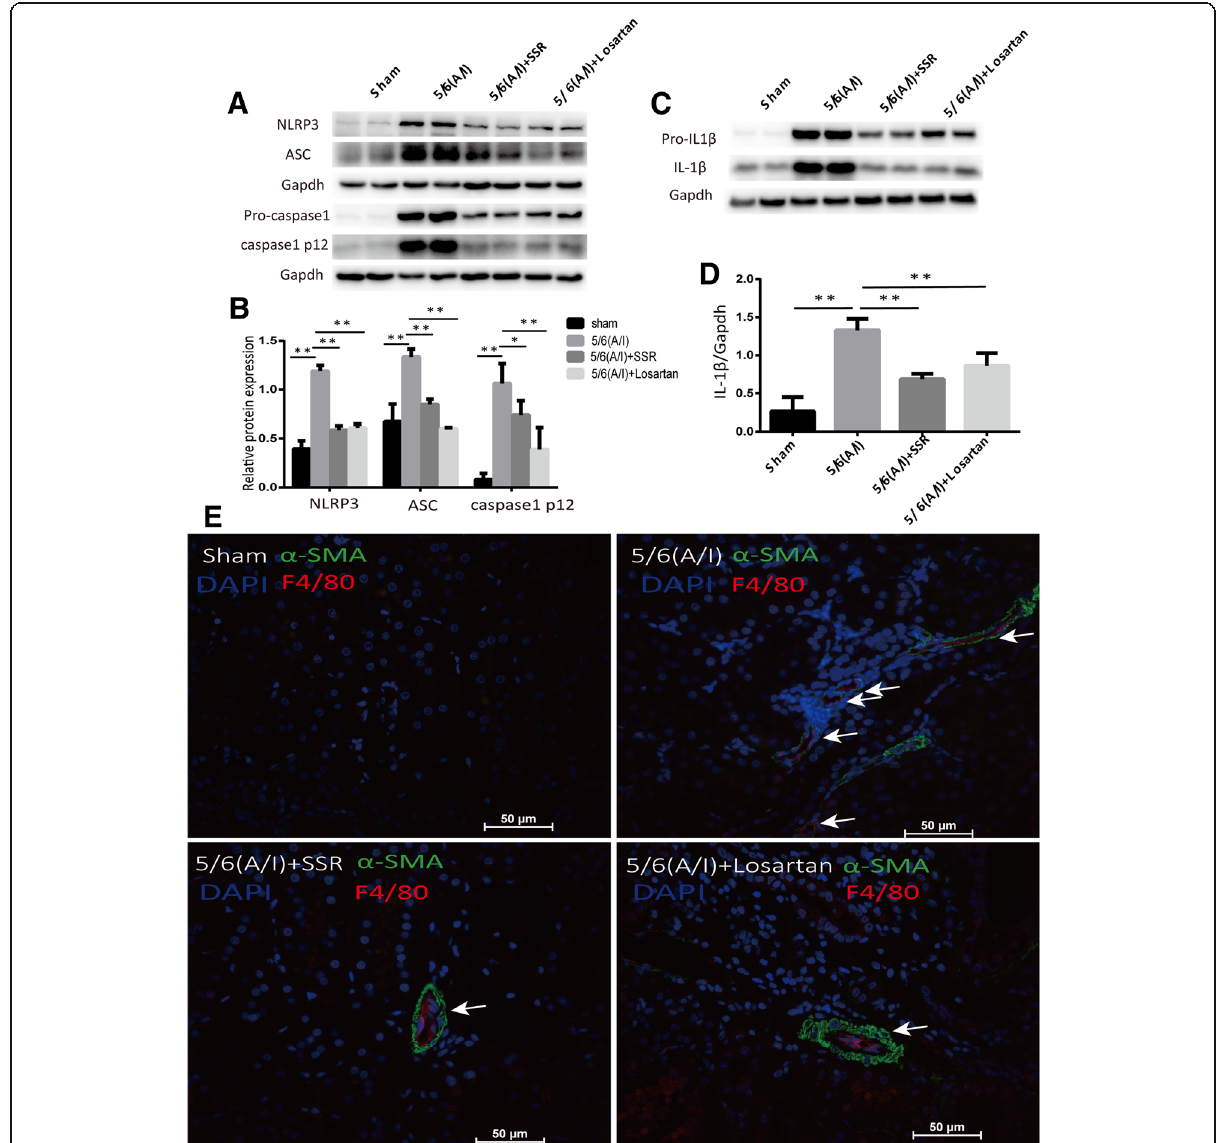
Fig. 2 SSR inhibited NLRP3 inflammasome activation and IL-1 β secretion in 5/6(A/I) rats. ( a ) The protein expression of NLRP3,ASC, Pro- caspase1 and Caspase-1 p12 was determined by immunoblotting. ( b ) Western blot quantification of NLRP3, ASC, and Caspase-1 p12 levels. ( n = 6) ( c ) The protein levels of Pro-IL1 β and IL1 β were determined by immunoblotting. (d) The ratio of IL-1 β to GAPDH protein was determined. (n = 6) ( e ) Representative images of IF staining for α -SMA and F4/80. Original magnification,× 400. Values are mean ± SD. * P < 0.05, ** P <